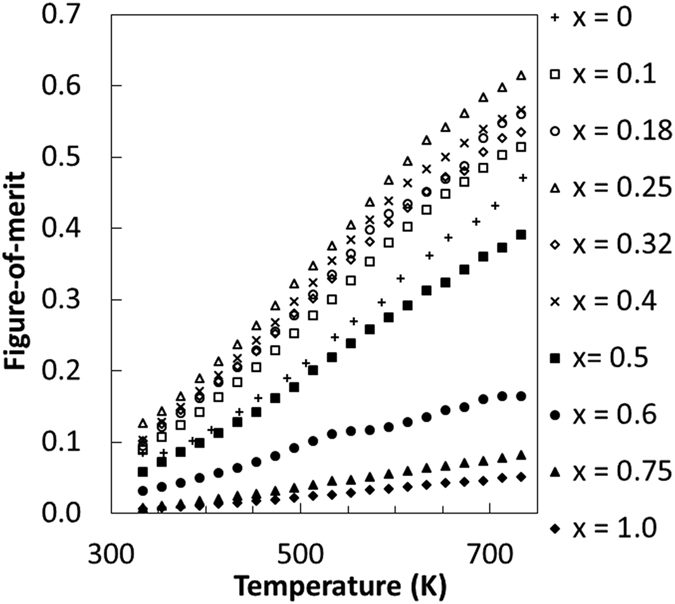
Figure of merit zT of CoSbS1−xSex doped with Te as a function of x and the temperature of measurement.